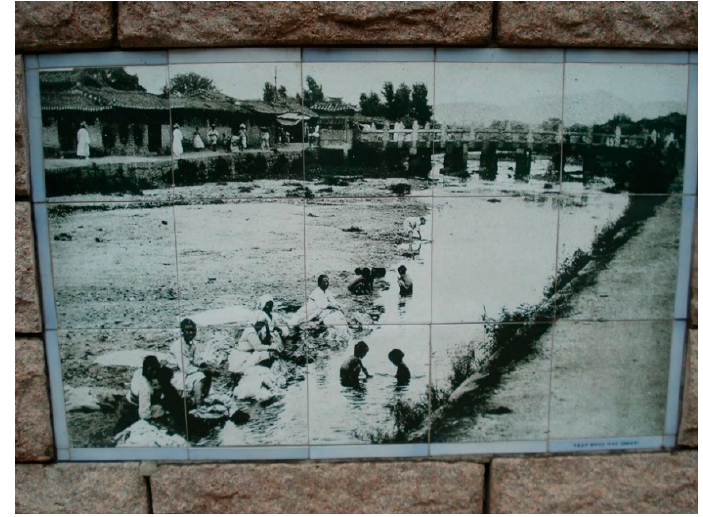
Figure 12. Image of women doing laundry, dated 1890, embedded into walls of the second section.